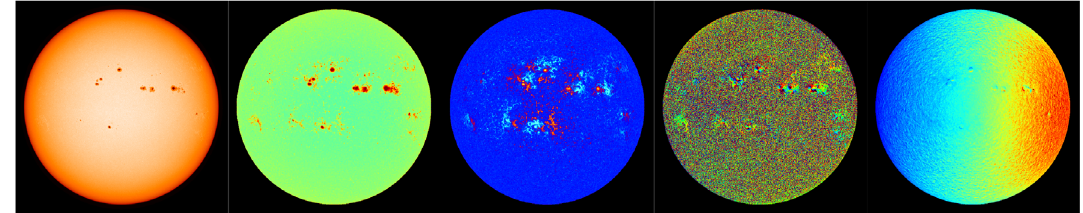
Fig. 4. Final data products (from left to right: continuum intensity, I c ; magnetic fi eld strength, B ; magnetic fi eld inclination, c ; magnetic fi eld azimuth, / and line-of-sight velocity, v LOS ) after on-board